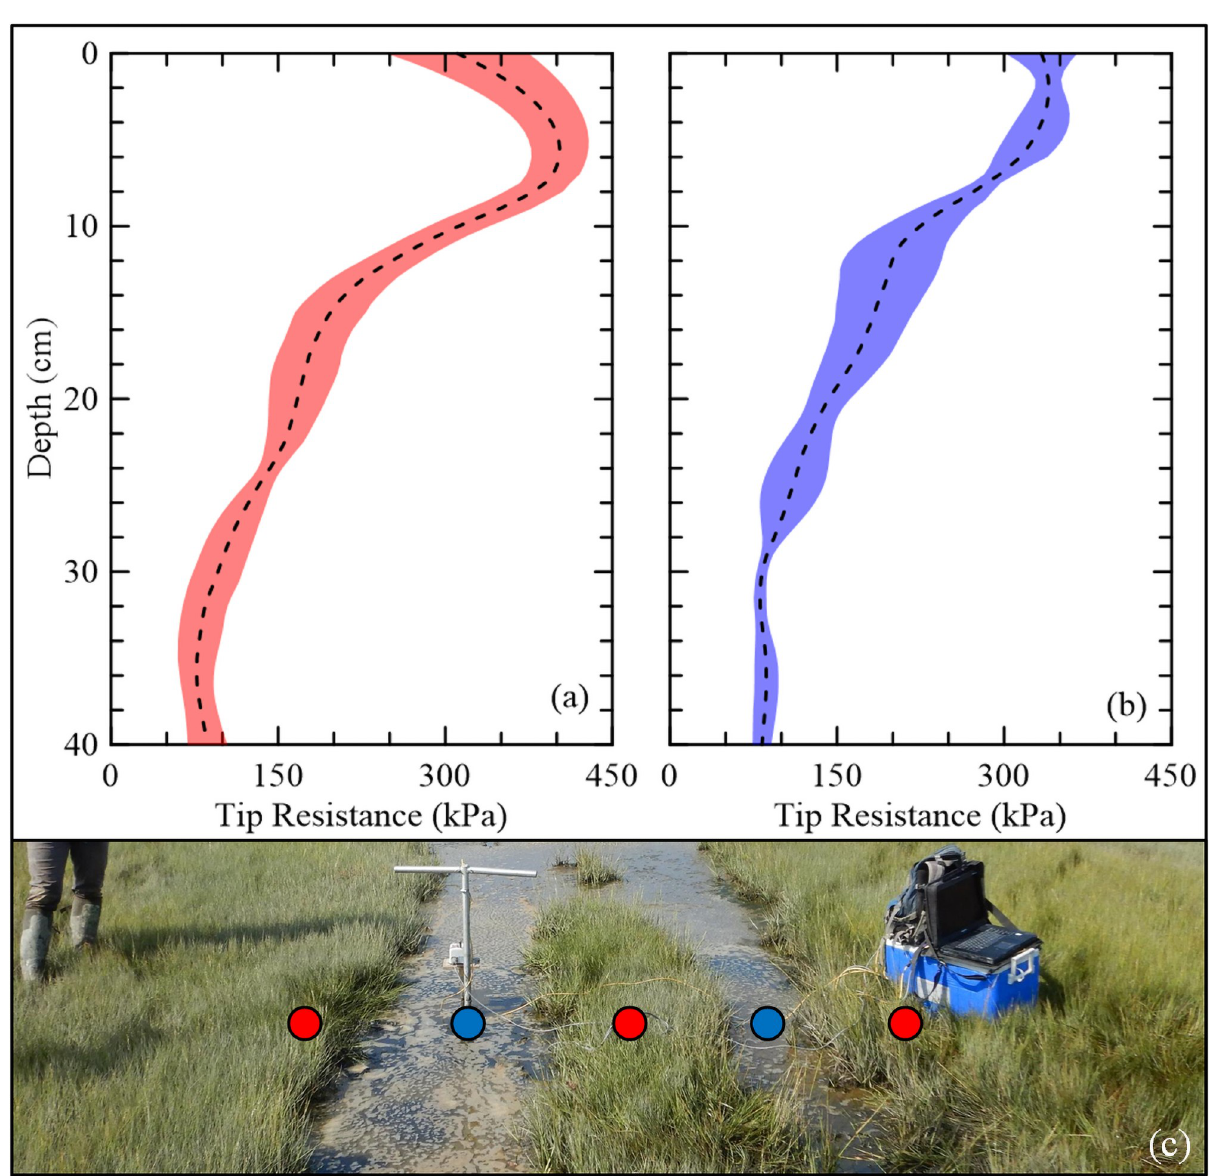
Fig 12. Average tip resistances for the (a) vegetated and (b) ponded zones, and (c) testing locations across construction tracks. Red and blue circles denote the vegetated and ponded zones, respectively. Shaded regions represent ± 1